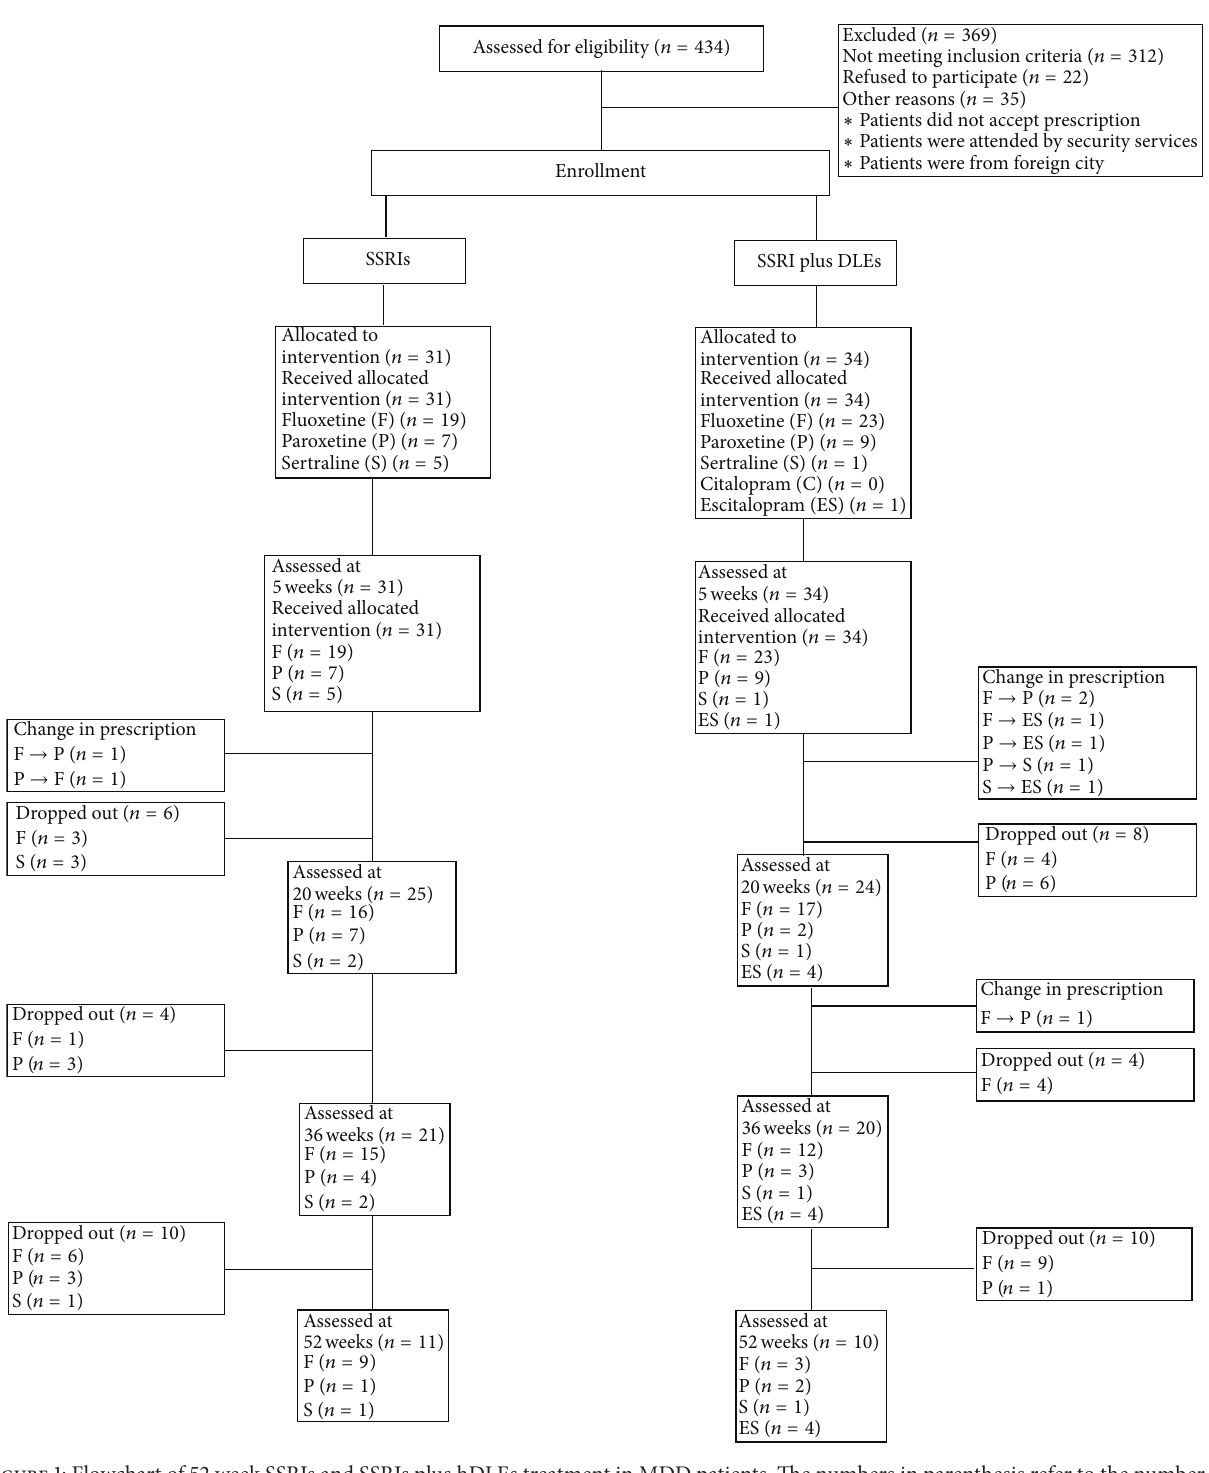
Figure 1: Flowchart of 52 week SSRIs and SSRIs plus hDLEs treatment in MDD patients. The numbers in parenthesis refer to the number of patients evaluated throughout the study, the changes in patient numbers for a pharmacological treatment, and the changes in patient numbers for treatment types withdrawn from the protocol. Change in prescription refers to the symbol >